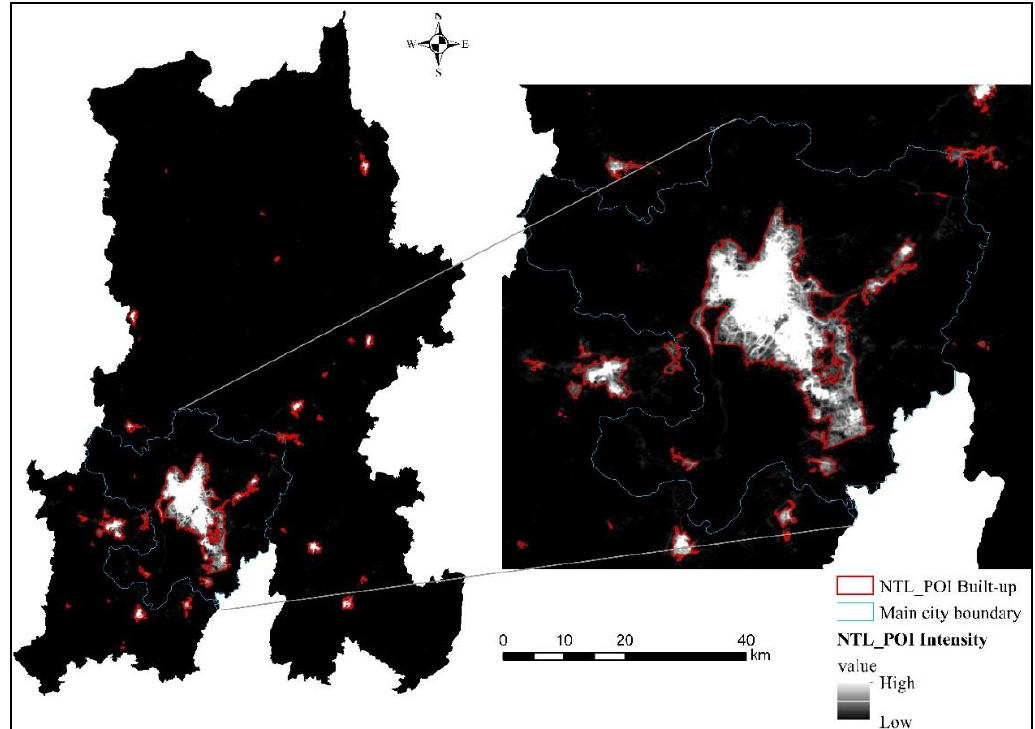
Figure 11. Results of urban built-up areas identified by NTL_POI.